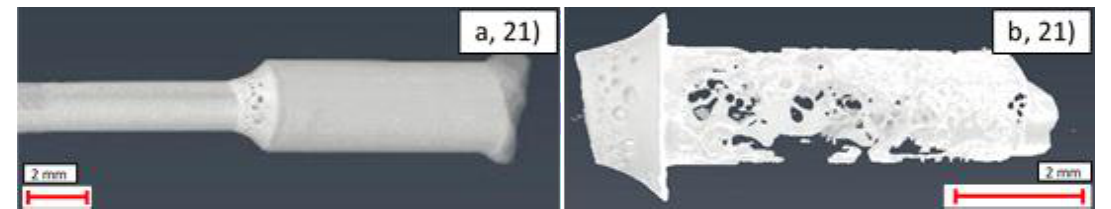
Figure 22. CT images of Ni + Au-coated sample (21): ( a ) side view of pipe and gland exterior; ( b ) side view of right side interior solder.